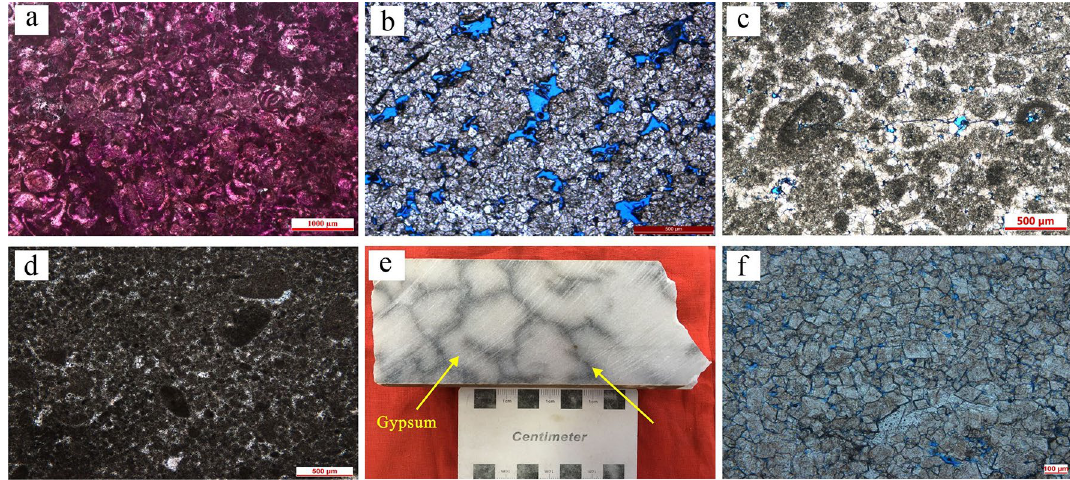
Figure 4. Macroscopic and microscopic characteristics of other carbonates in the Leikoupo Formation in Western Sichuan Basin. ( a ) Miliolinid packstone, T 2 l 43 , Well YS-1,6127.39 m; ( b ) Intraclast grainstone, T 2 l 43